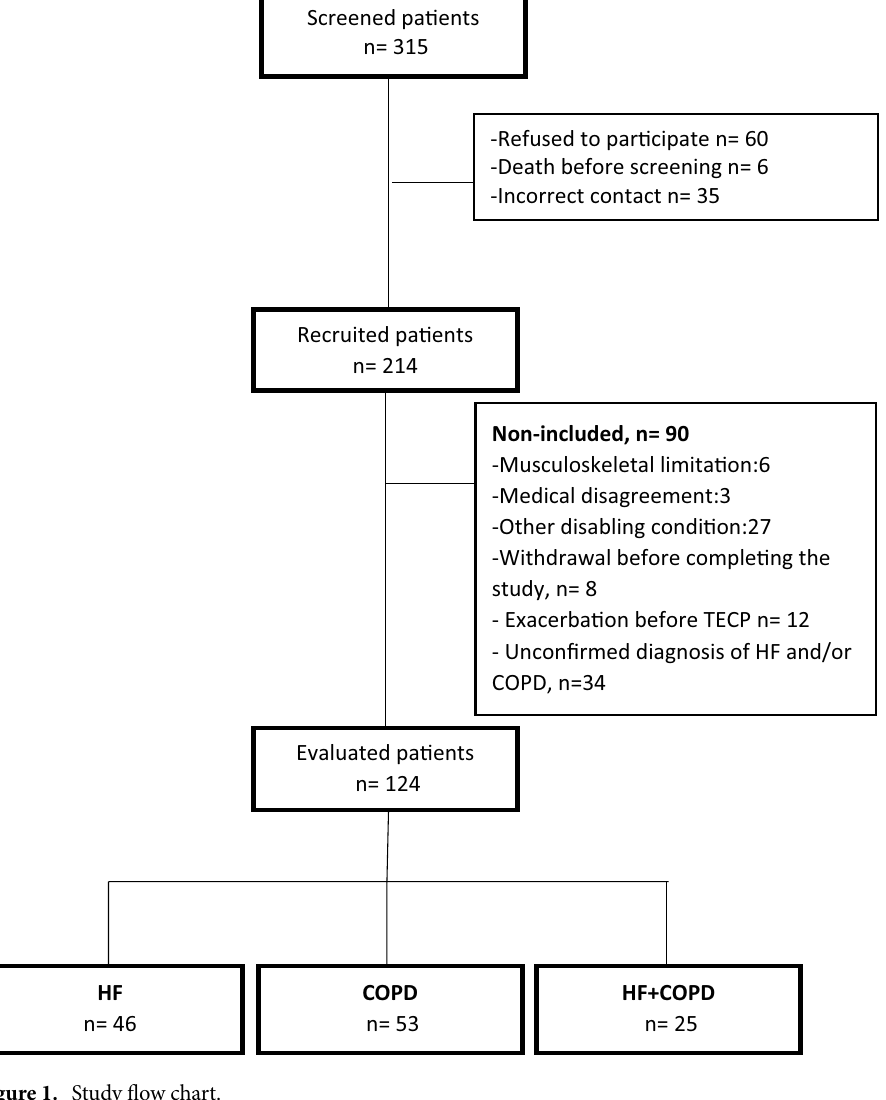
Figure 1. Study flow